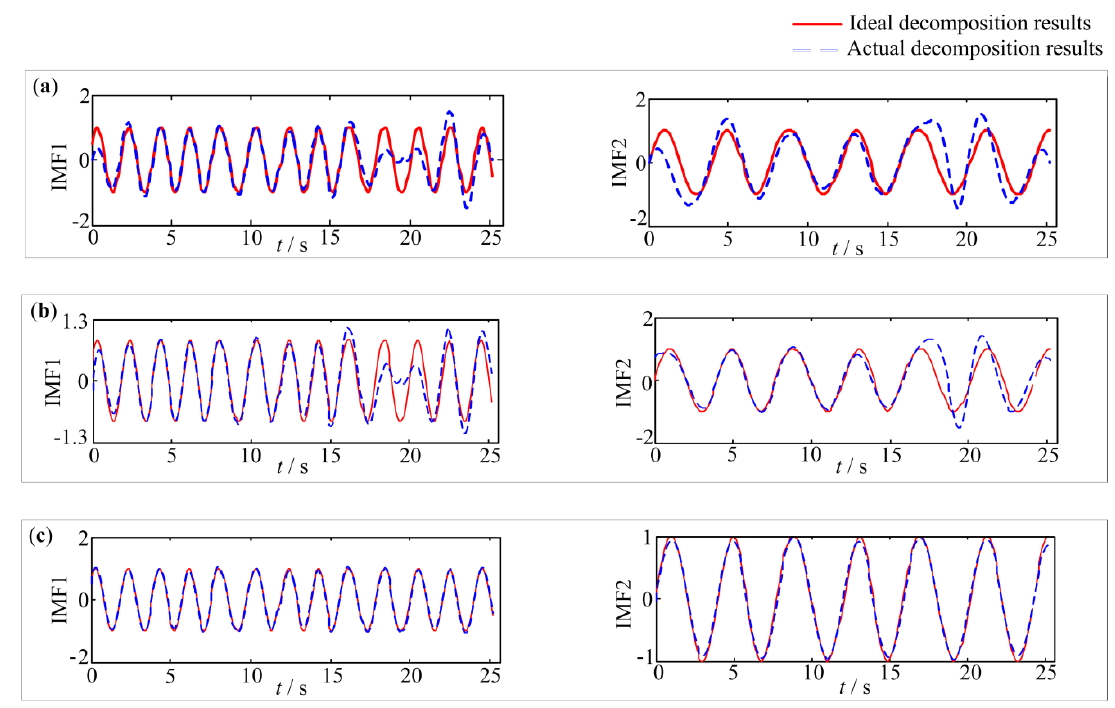
Figure 3. The decomposition results of ( a ) EMD1, ( b ) EMD2, ( c ) EMD3.